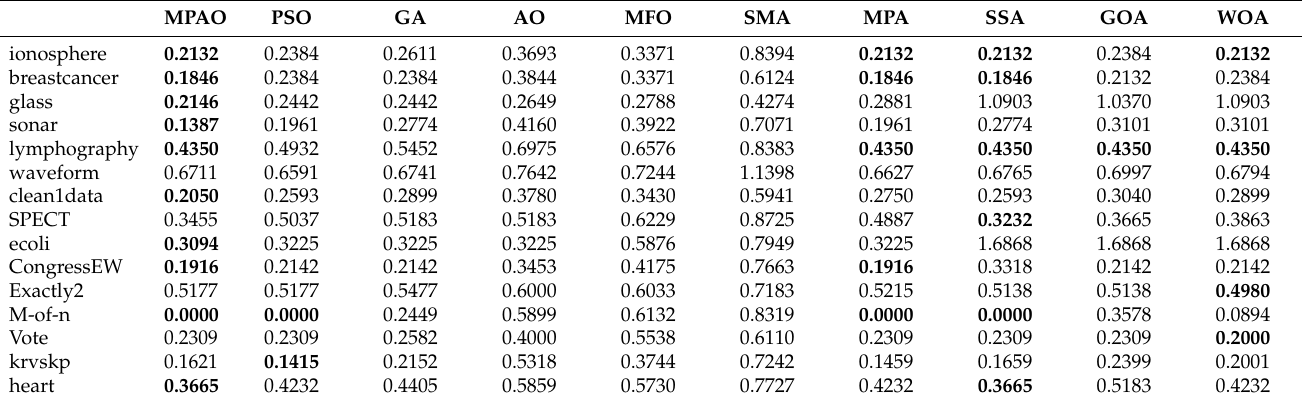
Table 9. Results of the maximum value of the fitness value.